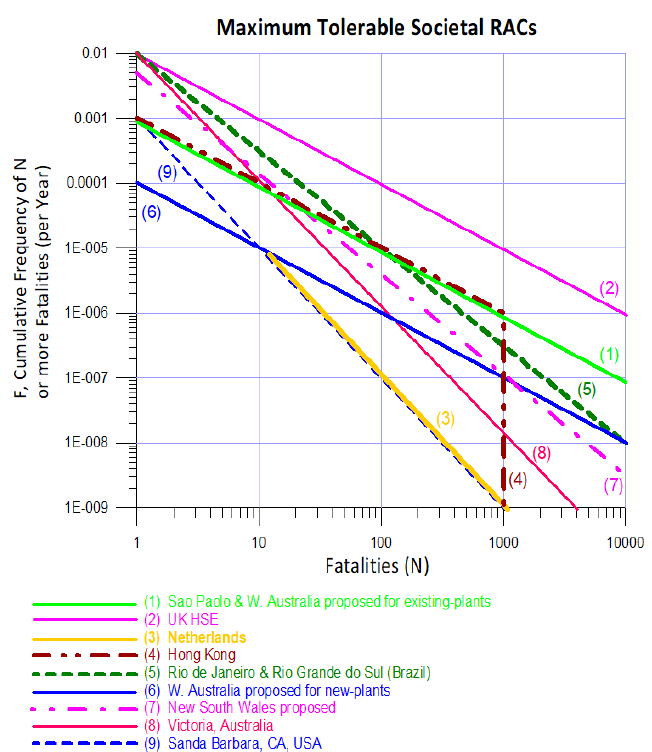
Figure 6. Maximum tolerable societal RACs for the public established in various countries. Table 2. EnvironmentalRACsconcerning the case of oil spills, according to NORSOK standard Z-013 [56]. Environmental Damage